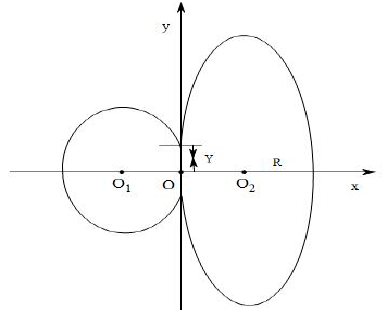
Figure 3. Section of two metal fibers in rectangular coordinates ( Y is the length of the sintering neck; O 1 and O 2 represent the centers of two ovals; R is the radius of oval).